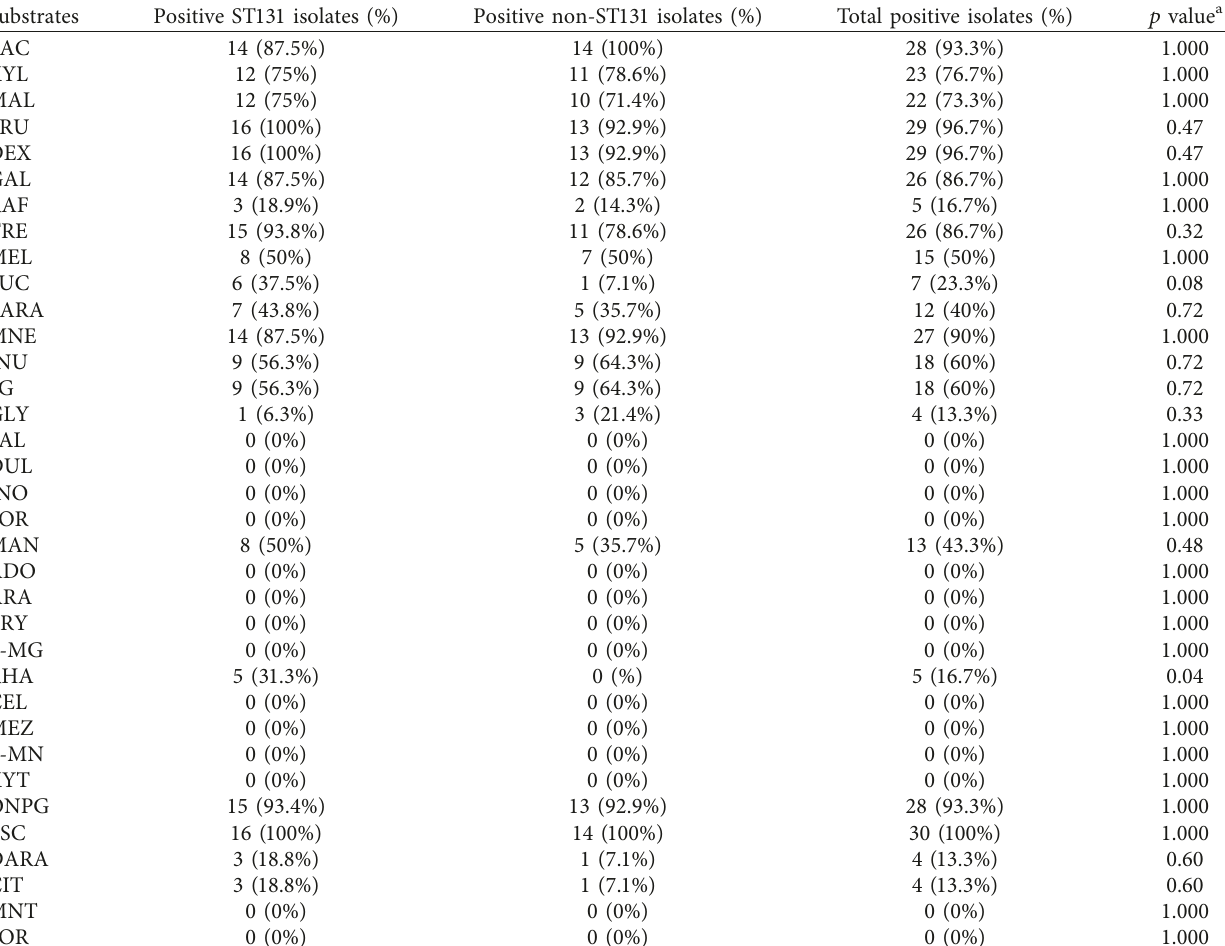
Table 4: Metabolic activity of ST131 and non-ST131 isolates.